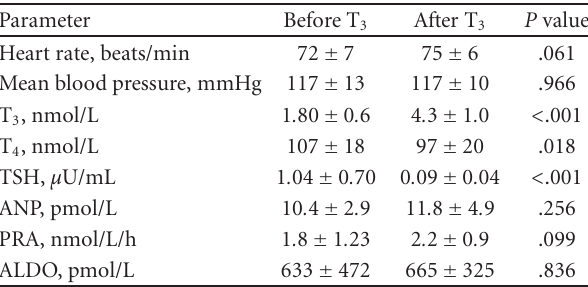
Table 1: Clinical and laboratory characteristics of the study population before and after T 3